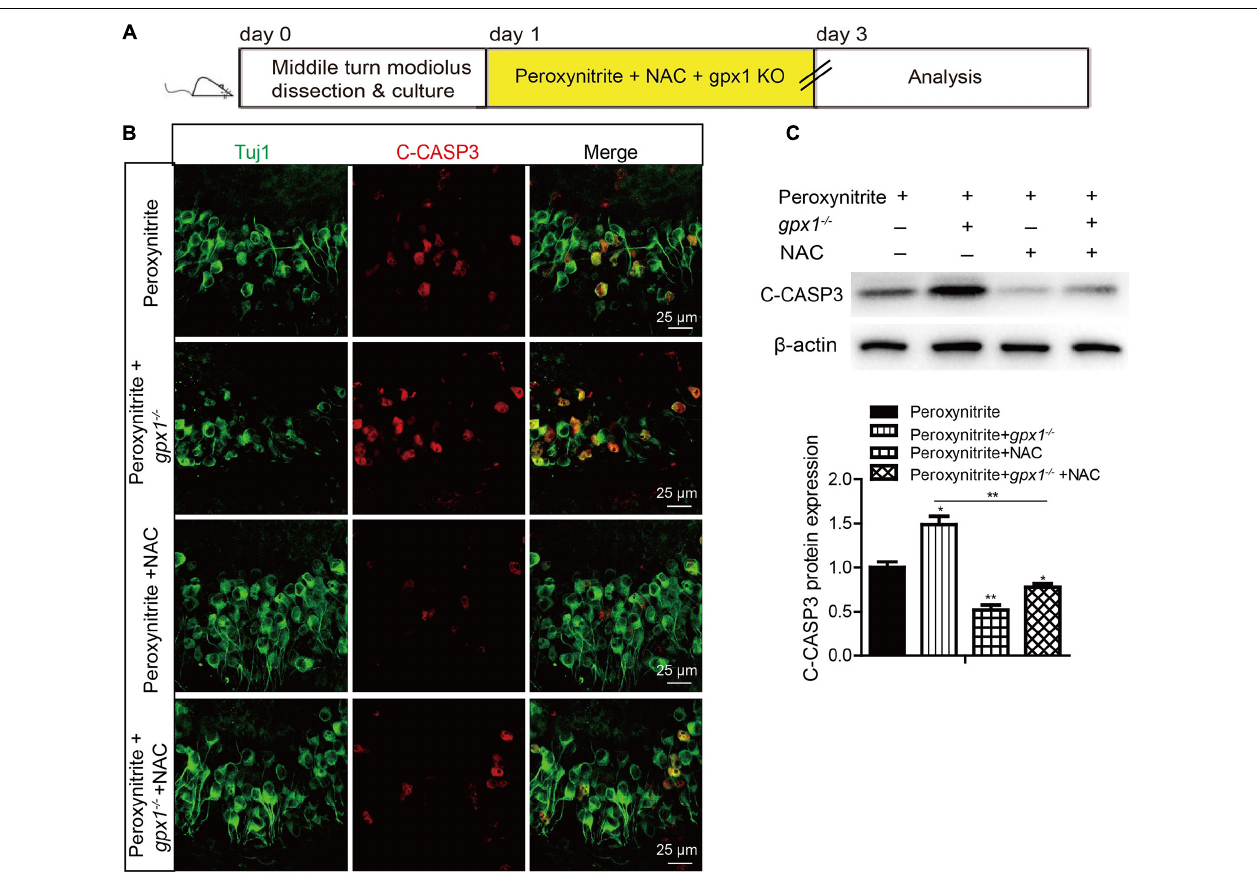
FIGURE 7 | N-acetylcysteine treatment reduced the apoptosis of SGNs in the lacking of GPX1 expression after peroxynitrite injury. (A) The cultured SGNs from WT or gpx1 − / − mice were treated with peroxynitrite and 2 mM NAC for 48 h. (B) Immunostaining results illustrated that there was much less C-CASP3-positive SGNs in the peroxynitrite + NAC group compared with the peroxynitrite-only group, as well as in the peroxynitrite + gpx1 − / − + NAC group compared with the peroxynitrite + gpx1 − / − group. Scale bar = 12.5 µ m. (C) Western blot results verified that the protein expression level of C-CASP3 was weaker in the peroxynitrite + NAC group compared with the peroxynitrite-only group, and it was also lower in the peroxynitrite + gpx1 − / − + NAC group compared with the peroxynitrite + gpx1 − / − group. * p < 0.05, and ** p < 0.01, n = 3 for each